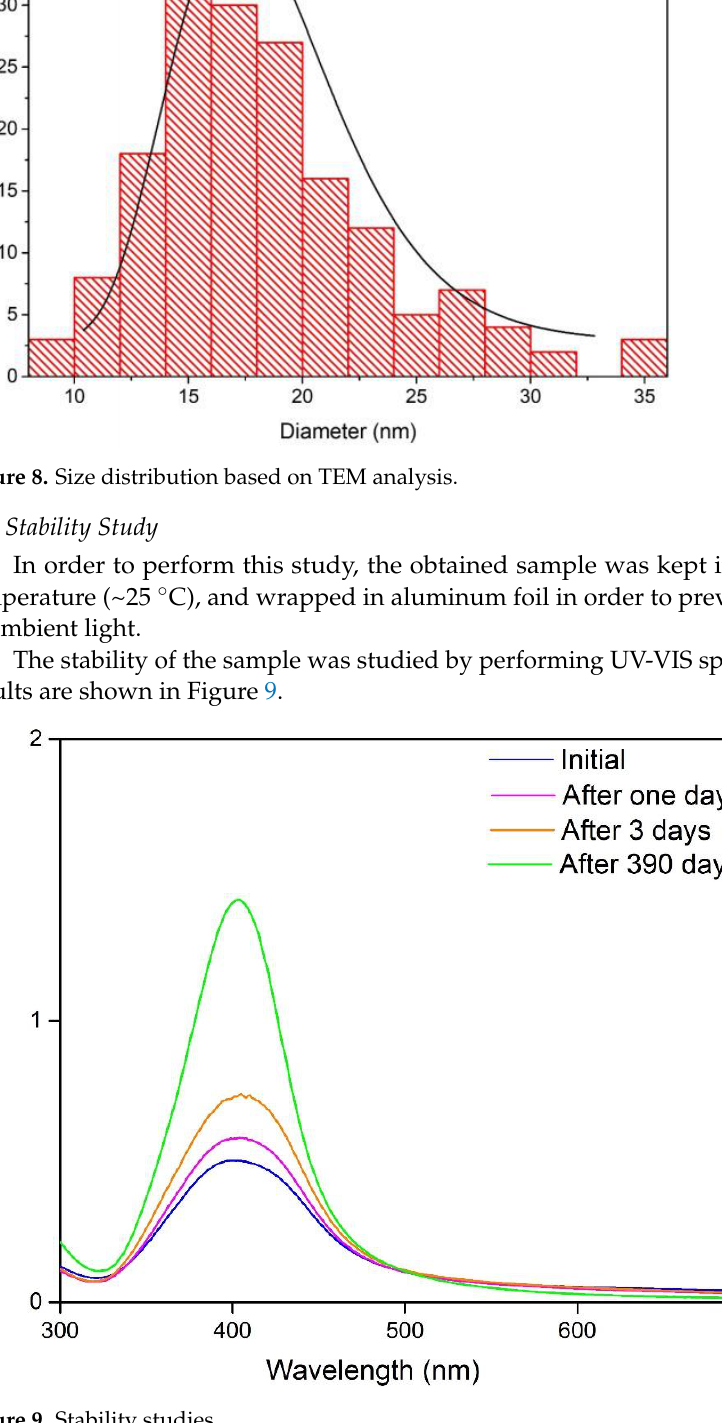
Figure 8. HRTEM images of AgNPs; the lattice fringes correspond to (111) and (200) crystallographic planes of FCC (face-centered cubic) AgNPs .